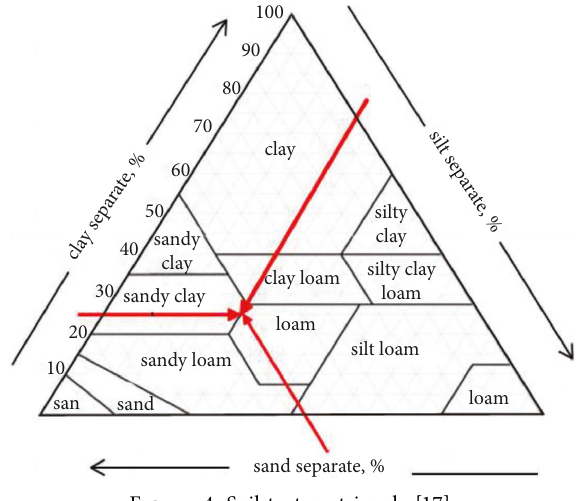
Figure 4: Soil texture triangle [17].